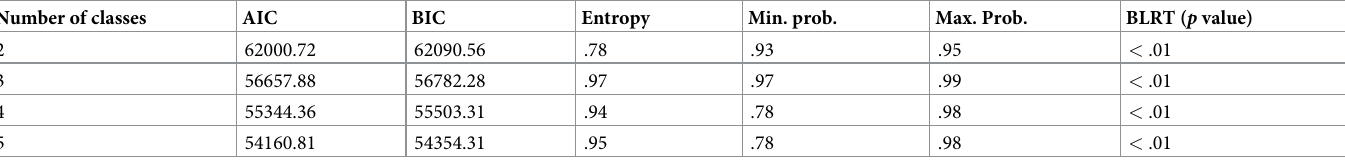
Table 7. Indices of classification quality for two to five class solutions, based on latent profile analysis. AIC